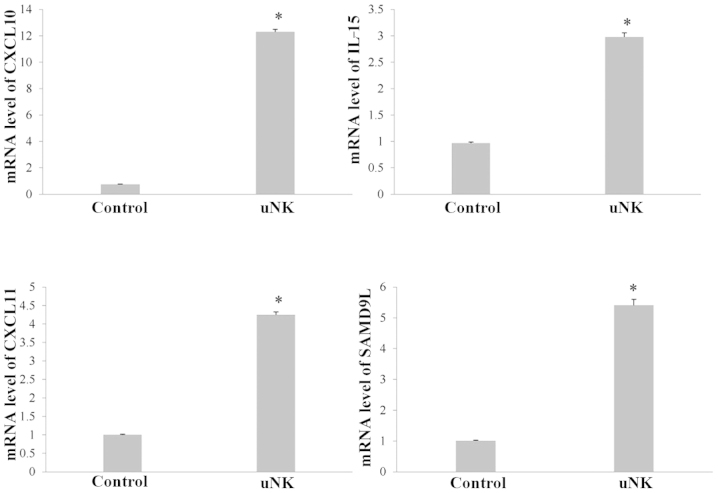
Transcript levels of CXCL10, CXCL11, IL-15 and SAMD9L determined by RT-qPCR. The RT-qPCR results were consistent with those of the microarray analysis. Data are expressed as the mean ± standard error of the mean. *P<0.01, compared with the control group. uNK, uterine natural killer cells; CXCL, chemokine (C-X-C) motif ligand; IL-15, interleukin 15; SAMD9L, sterile α motif domain containing 9-like; RT-qPCR, reverse transcription-quantitative polymerase chain reaction.